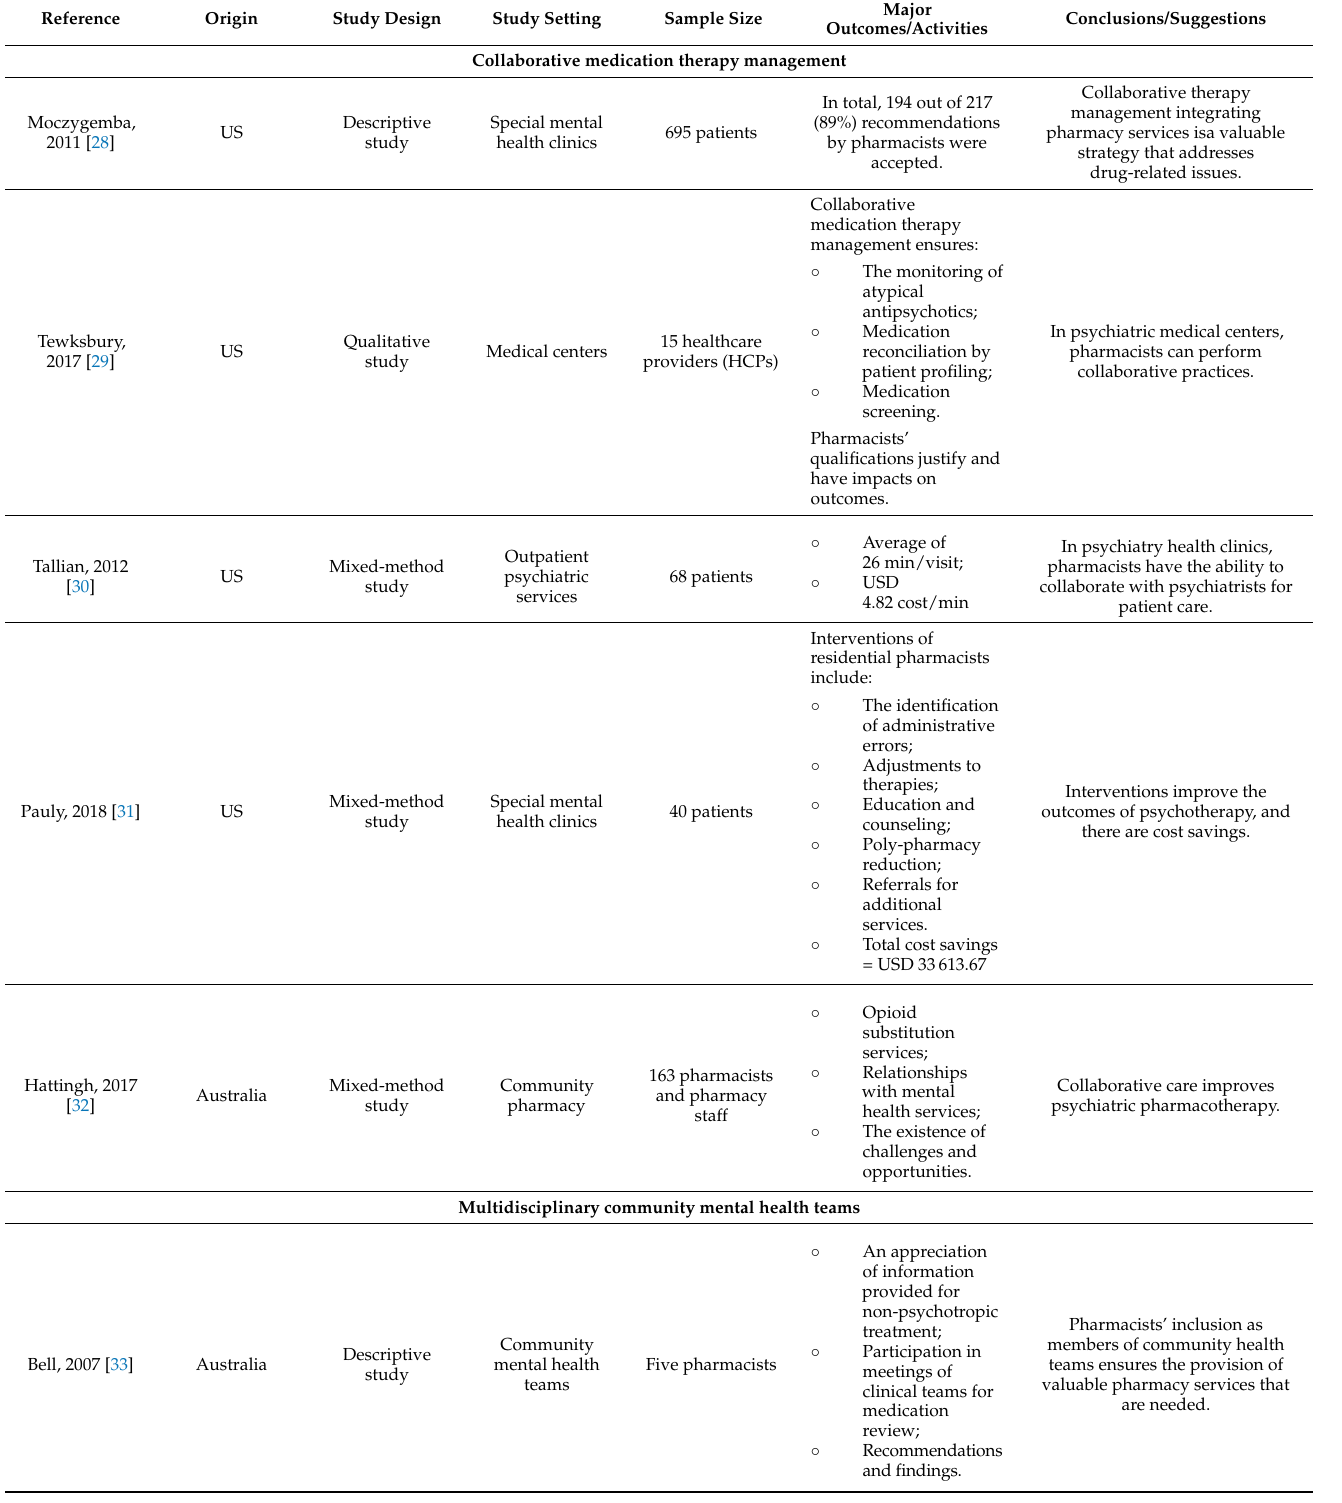
Table 3. Summary of studies’ characteristics (extended